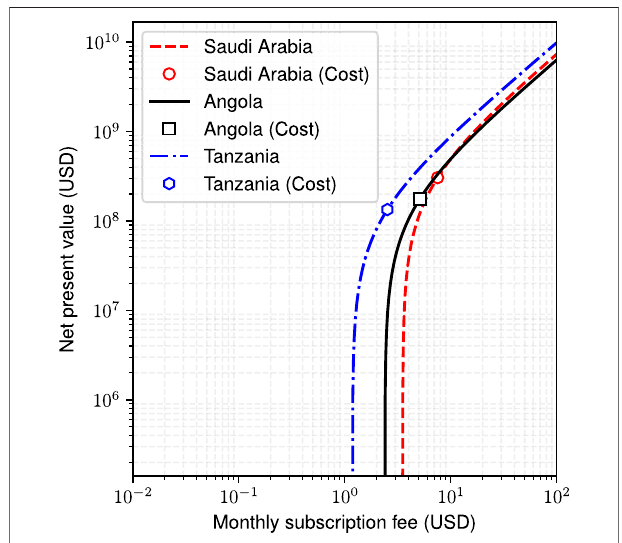
FIGURE 2 | Net present value versus monthly subscription fee by deploying balloons over rural areas of the three considered countries: Saudi Arabia, Angola, and